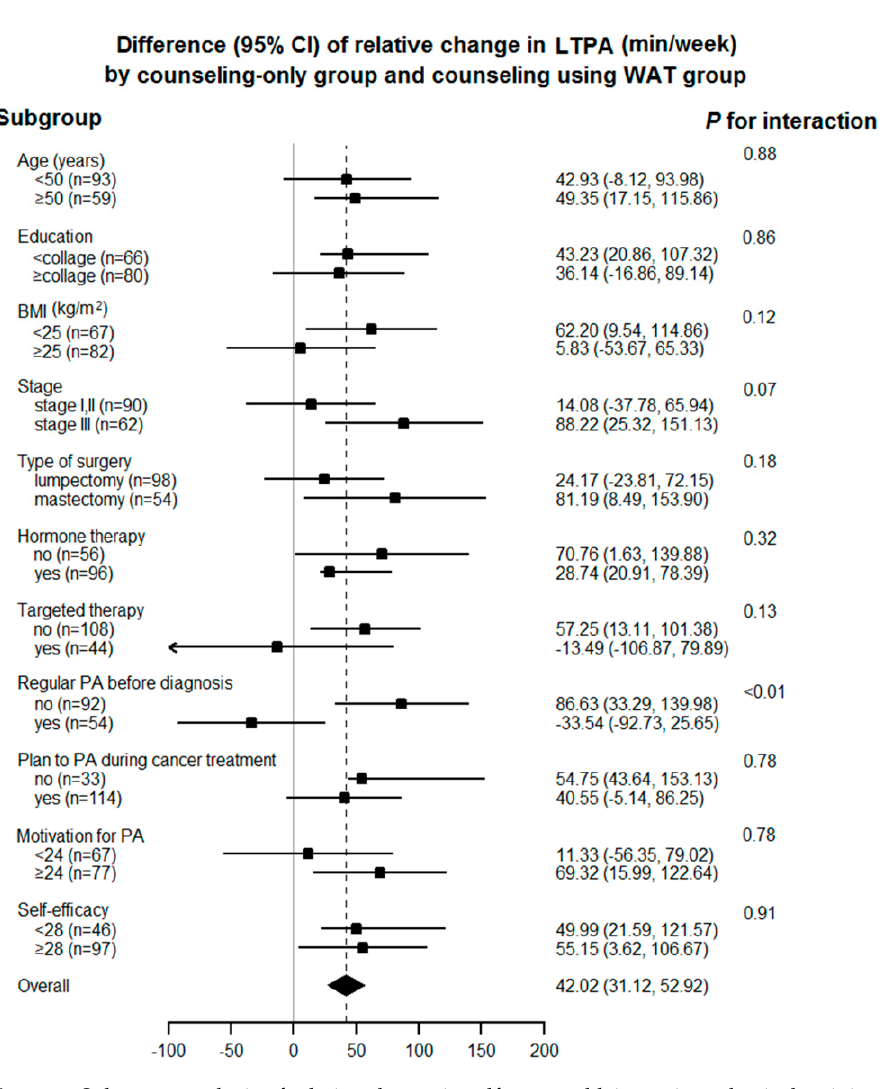
Figure 2. Subgroup analysis of relative change in self-reported leisure time physical activity at end of radiation therapy.